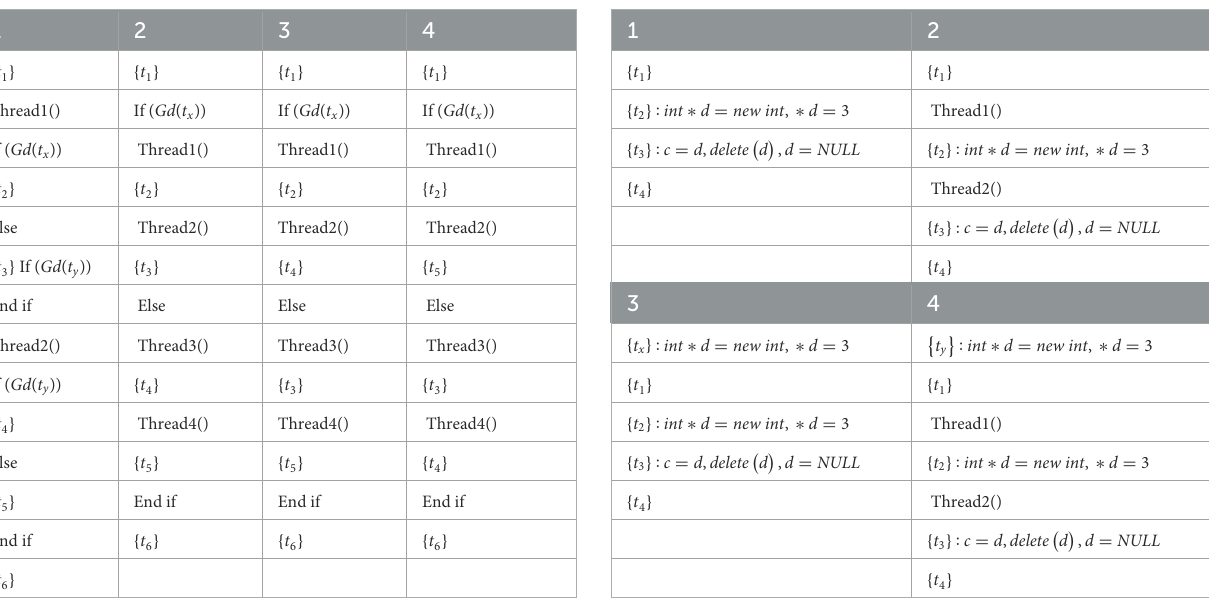
TABLE 2 Four kinds of pseudo-codes with guard functions. TABLE 3 Four kinds of pseudo-codes with data